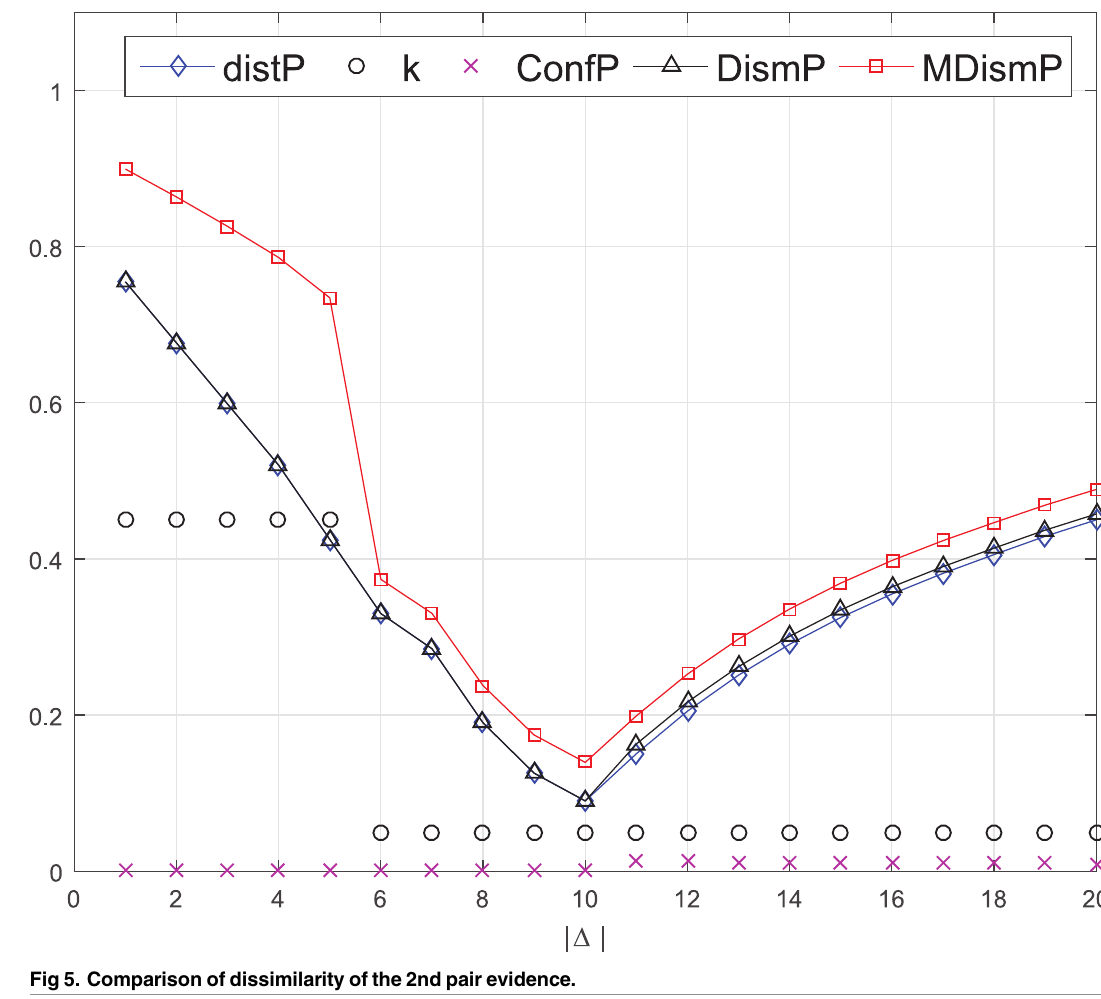
Fig 5. Comparison of dissimilarity of the 2nd pair evidence.